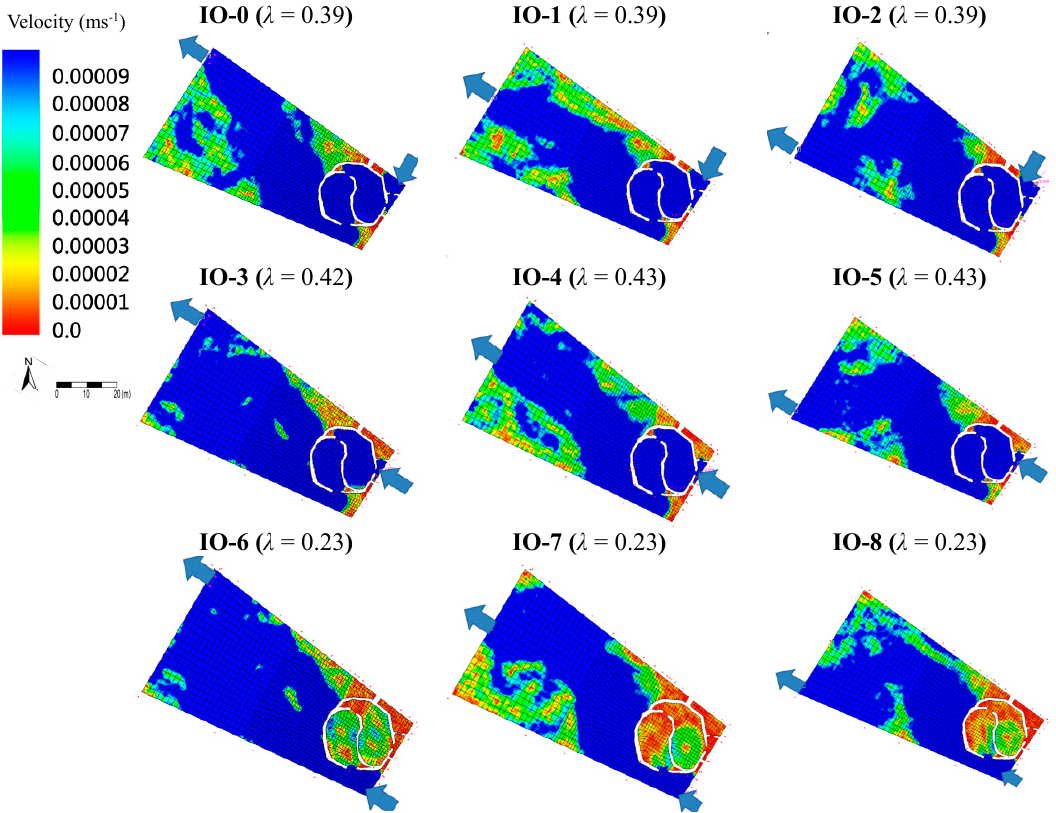
Figure 6. Spatial distribution of the flow velocity in the treatment pond for different inlet and outlet configurations. Case IO ‐ 0 represents the current conditions of the pond, and the other cases represent scenarios for improving the hydraulic efficiency. The blue arrows indicate the flow inlet and outlet. The hydraulic efficiency is shown in parentheses according to the name of each scenario.